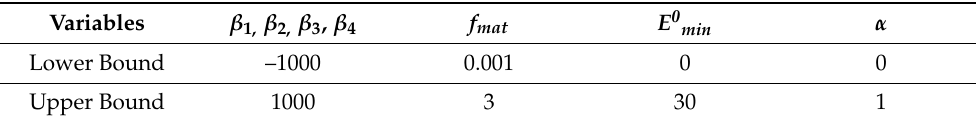
Table 2. Listing the lower and upper bounds of the 6 different variables used during the optimization routine.